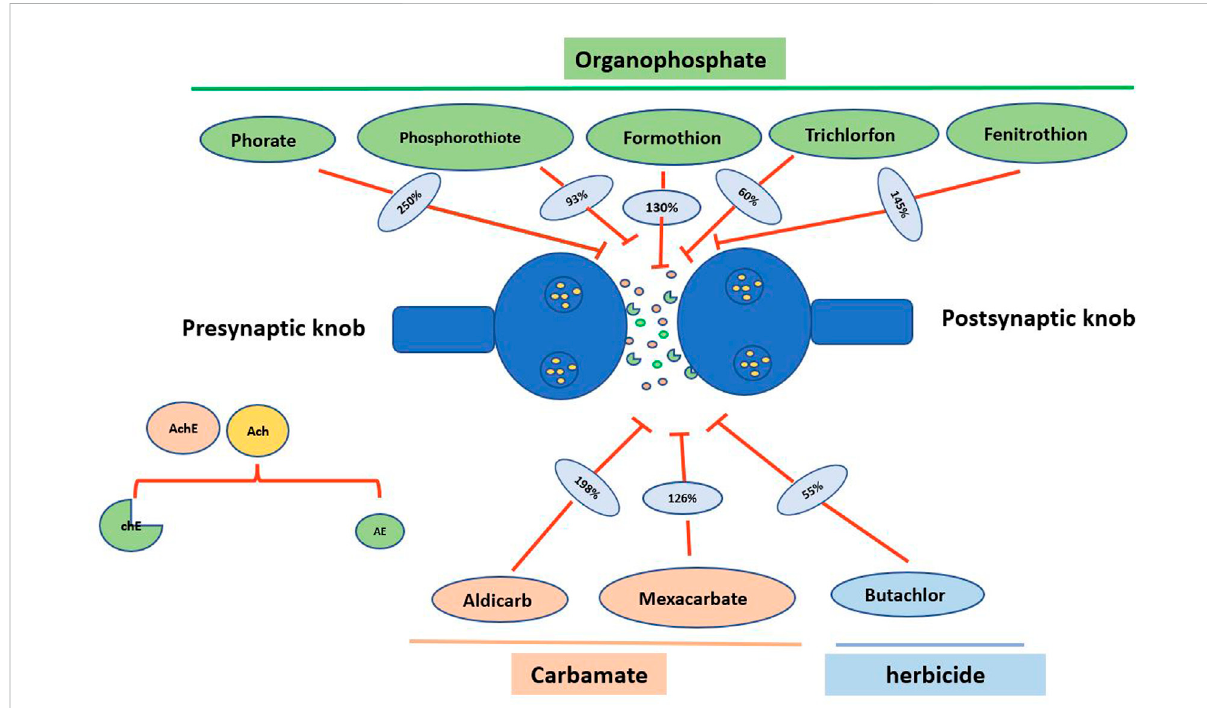
FIGURE 4 Action of pesticides on acetylcholinesterase activity during nerve impulse. Acetylcholine (Ach) aneurotransmitter enzyme that is released from the presynaptic knob where it splits into acetyl coenzyme A (AE) and choline (chE) with the help of the enzyme acetylcholinesterase. Organophosphates (Phorate, phosphorothiote, formothion, trichlorfon and fenitrothion), carbamates (aldicarb and mexacarbate), and herbicide (butachlor) inhibit the action of acetylcholinesterase enzyme thus, block the nerve impulse in the organism. % Inhibition by pesticides is designated in respective blue color oval